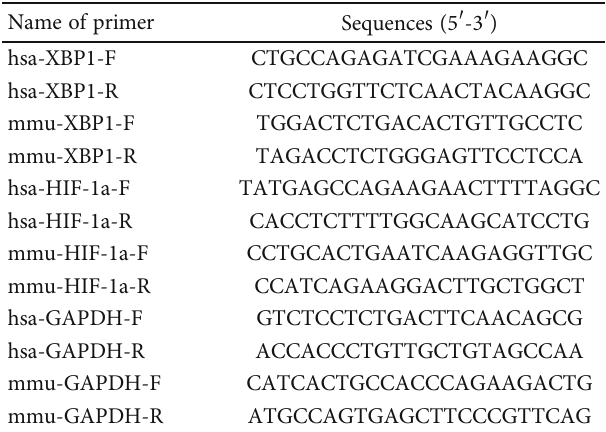
Table 1: Primer sequences used for